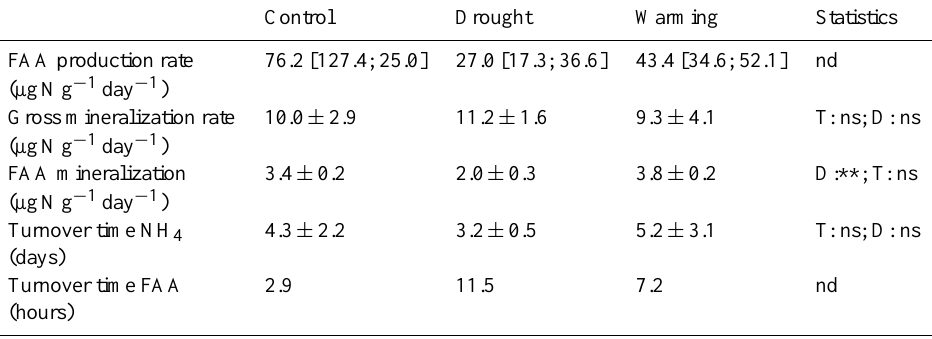
Table 2. Nitrogen transformation rates and turnover times. Gross mineralization rate (Eqs. 1 and 2), free amino acid (FAA) mineralization (Eq. 4), represented by average ± standard error. FAA production rate is the sum of the five AAs, the two measurement points in square brackets, NH + turnover time (days) and turnover time of amino acids (hours). Significant effect ( P < 0.01) of treatment is indicated by 4 asterisks (**). ns is non-significant, and nd is non-determined.